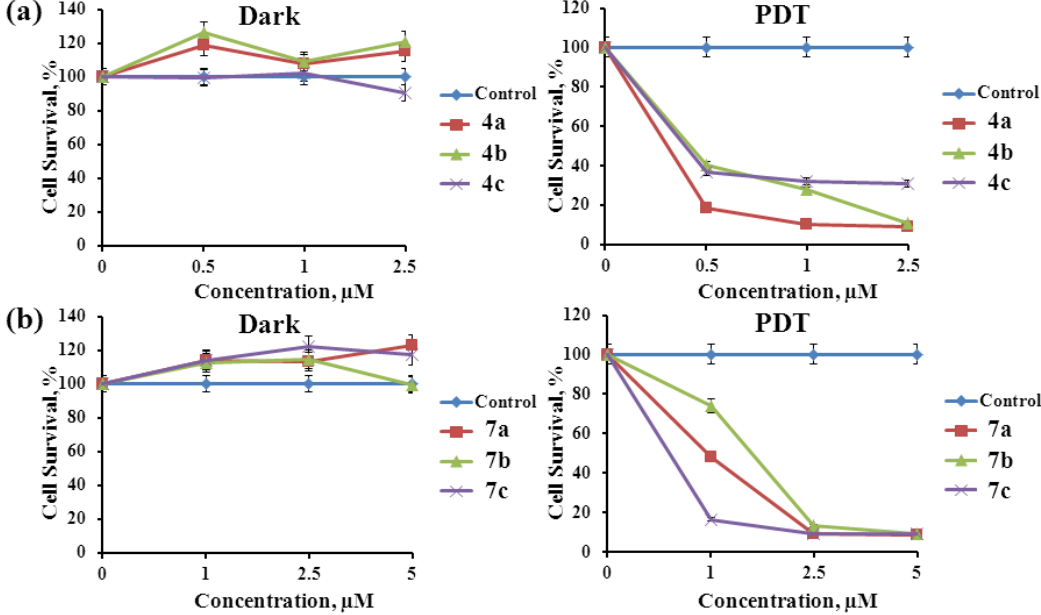
Figure 4. Comparative in vitro dark cytotoxicity and phototoxicity results for 4a – 4c and 7a – 7c at various drug doses (1–20 μ M) against A549 cell lines by MTT (3-(4,5-dimethylthiazole-2-yl)-2,5-biphenyl tetrazolium bromide) assay at 12 h incubation